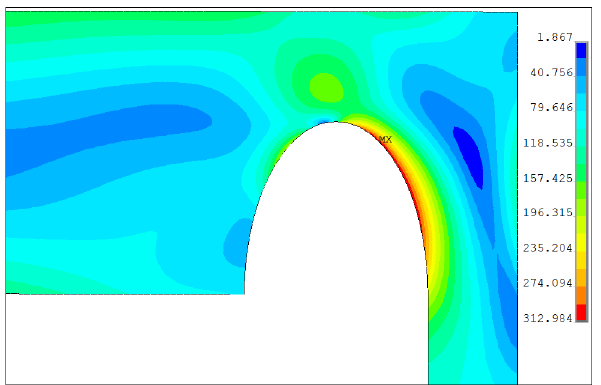
Figure 23. Distribution of equivalent stresses in the elliptical SRG for optimally chosen semi-axes.